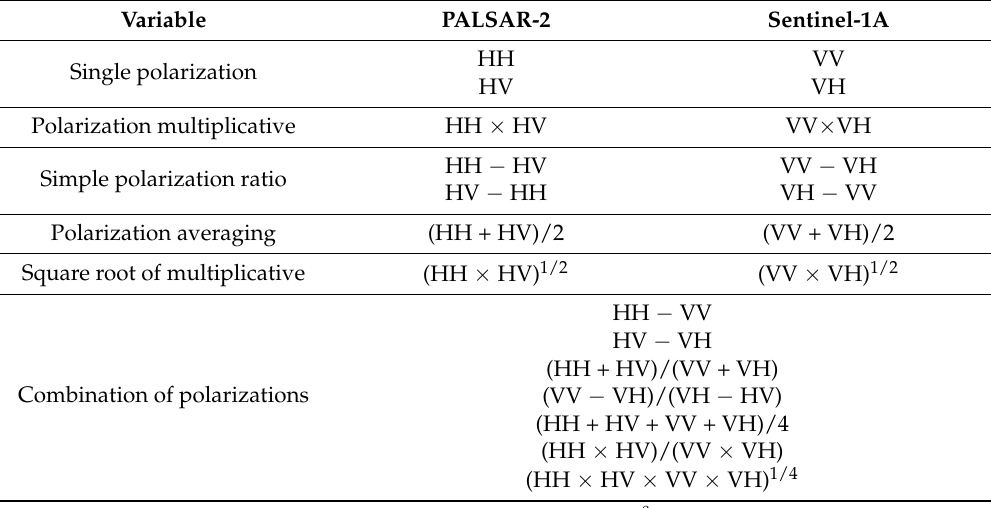
Table 4. Variables that were derived from PALSAR-2 and